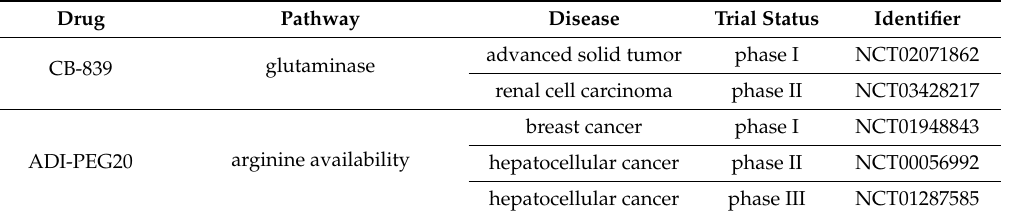
Table 2. Clinical trials of drugs that target other metabolic pathways than glycolysis, involved in the upregulated synthesis, proliferation, and survival of cells that have undergone metabolic